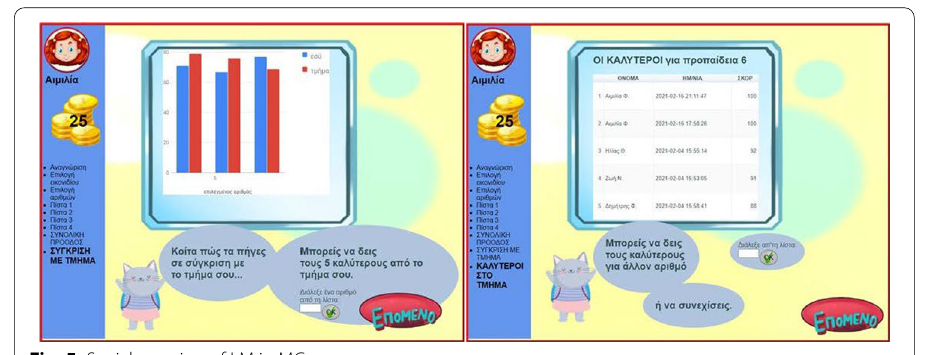
Fig. 5 Social opening of LM in